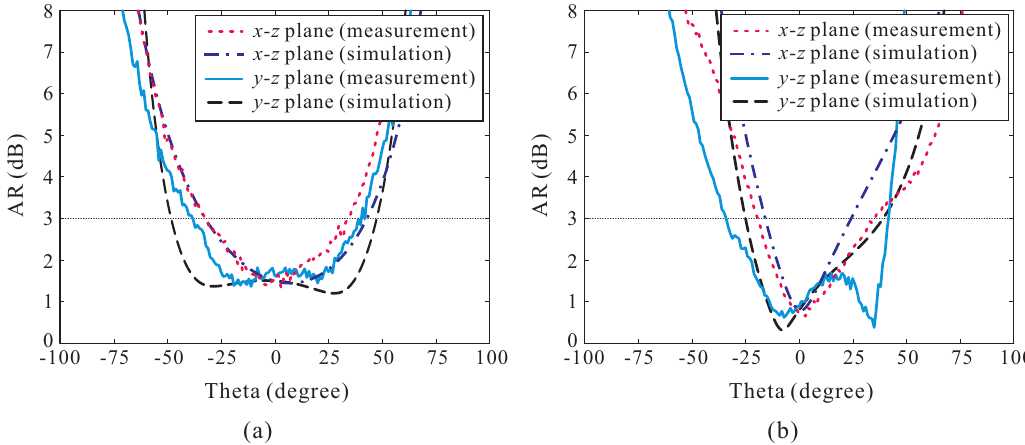
Figure 10. Simulated and measured ARs of the proposed antenna versus observation angle: ( a ) 2.1 GHz; ( b ) 3.7 GHz.